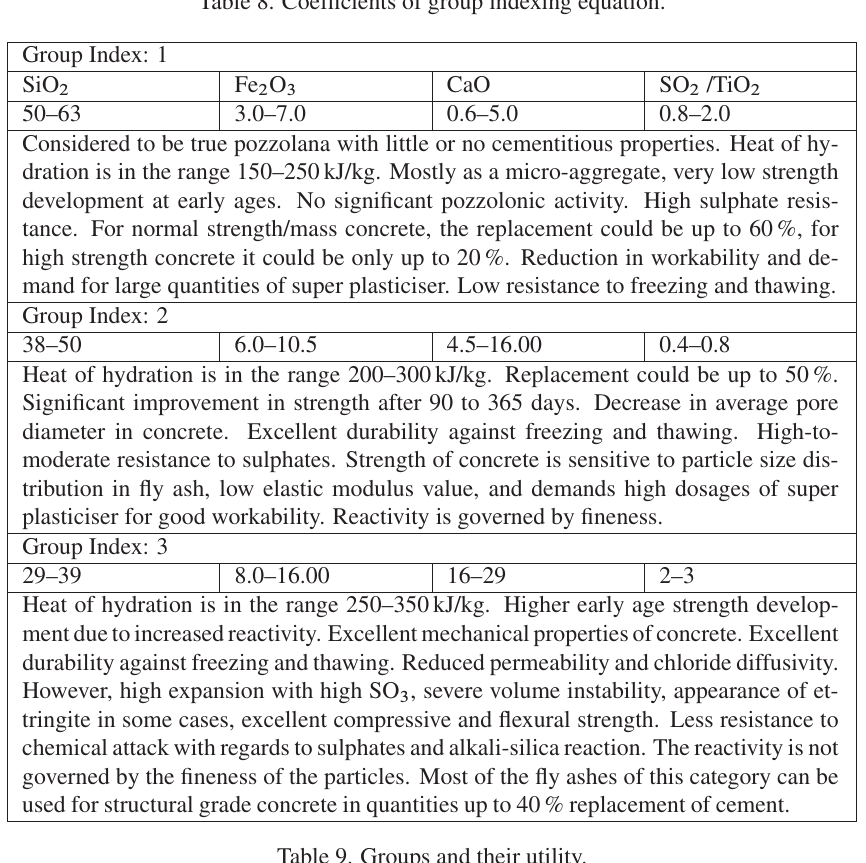
Table 8. Coefficients of group indexing equation.